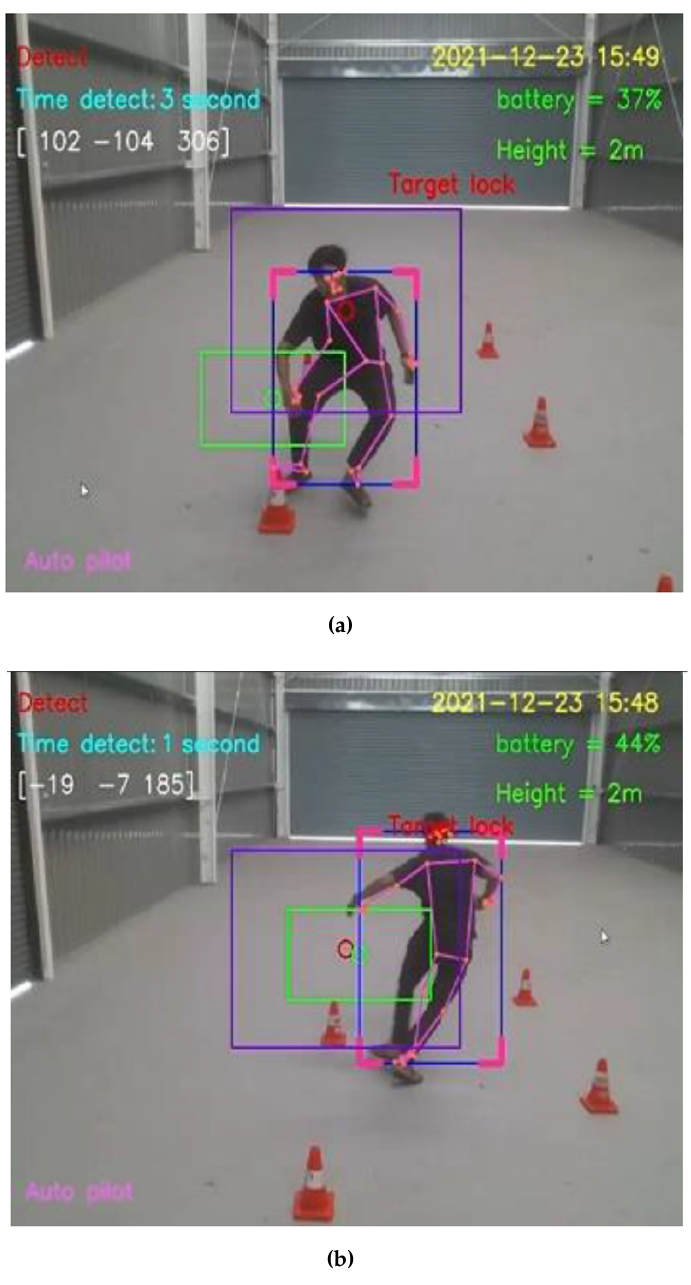
Figure 17. Zigzag moving directions: ( a ) Zigzag running forward to the Tello EDU drone ( b ) Zigzag running away from the Tello EDU drone. For straight walking through the Tello EDU drone’s camera, the average speed of straight walking from left to right and that from right to left were 1.1834 and 1.2019 m/s, respectively. For straight running through the Tello EDU drone’s camera, the average speed of straight running from left to right and that from right to left were 2.0661 and 2.1231 m/s, respectively, as illustrated in Figure